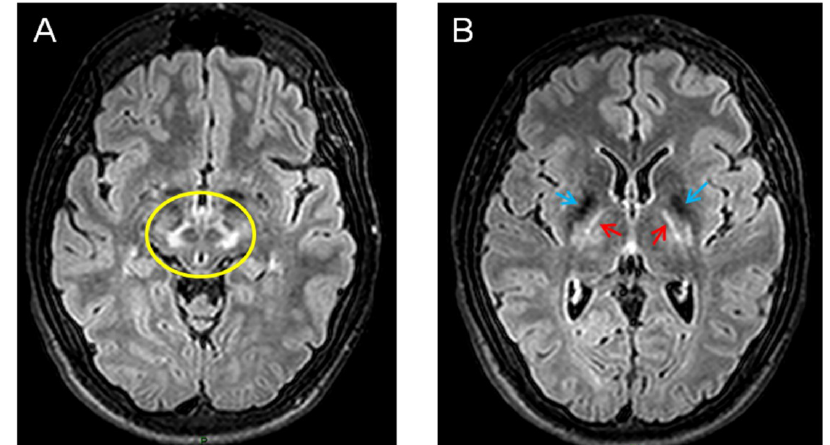
Figure 2. Brain MRI (axial flair images) showing zones of impaired signal at the level of mesencephalon ( A ) and thalami ( B ) in a 21-year-old patient presenting Wilson’s disease. In the left panel, note the relative sparing of red nuclei and part of pars reticulata (giving a typical aspect called the ―Panda sign‖). In the right panel, the simultaneous hyposignals of basal ganglia (blue arrows) and the hypersignals in thalamic nuclei and internal capsule (red arrows) are very